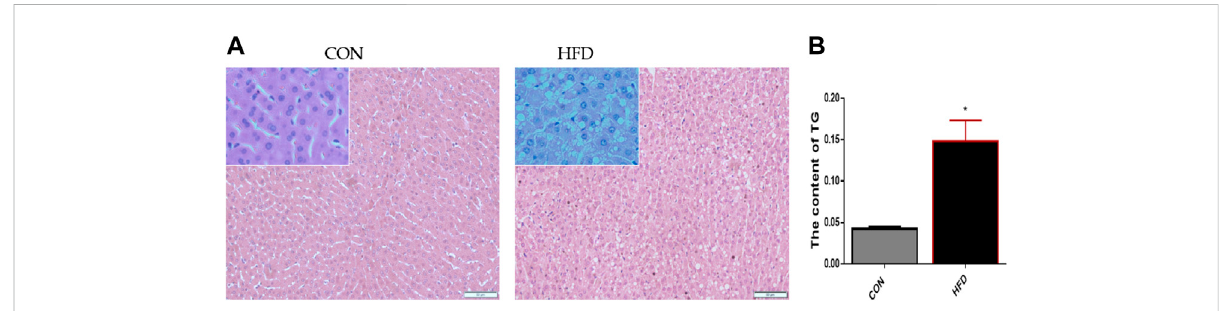
FIGURE 1 MorphologicobservationoftheCONandHFDrabbits ’ liver (A) Paraf fi nsectionstainedwithHEshowedtheobviousdifferencebetweentheliver tissues. (B) Triglyceride test results showed that there were signi fi cant differences. The data are presented as means ± SEM. * p < 0.05; ** p <